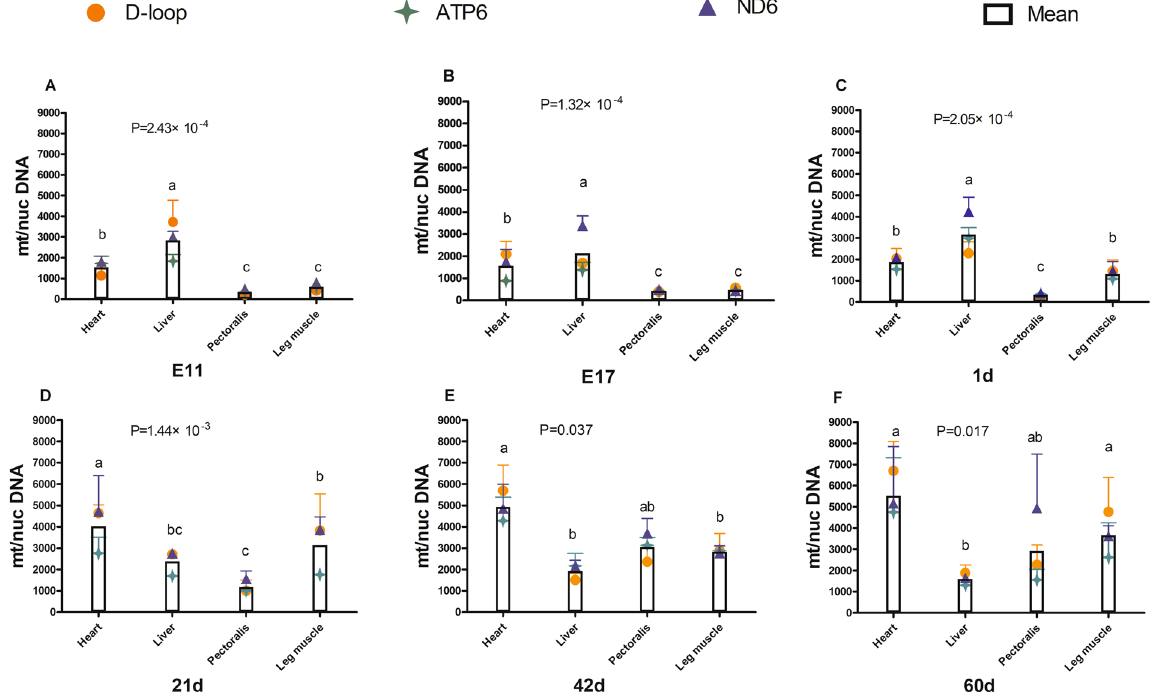
Figure 3. Variation in mtDNA copy number among tissues from broilers of different ages. ( A ) E11; ( B ) E17; ( C ) 1 d; ( D ) 21 d; ( E ) 42 d; ( F ) 60 d. mt/nucDNA = mtDNA relative to nuclear DNA ( GCG ) copy number. Different letters indicate significant differences ( P < 0.05), and the same or no letter indicates P > 0.05. n = 3.